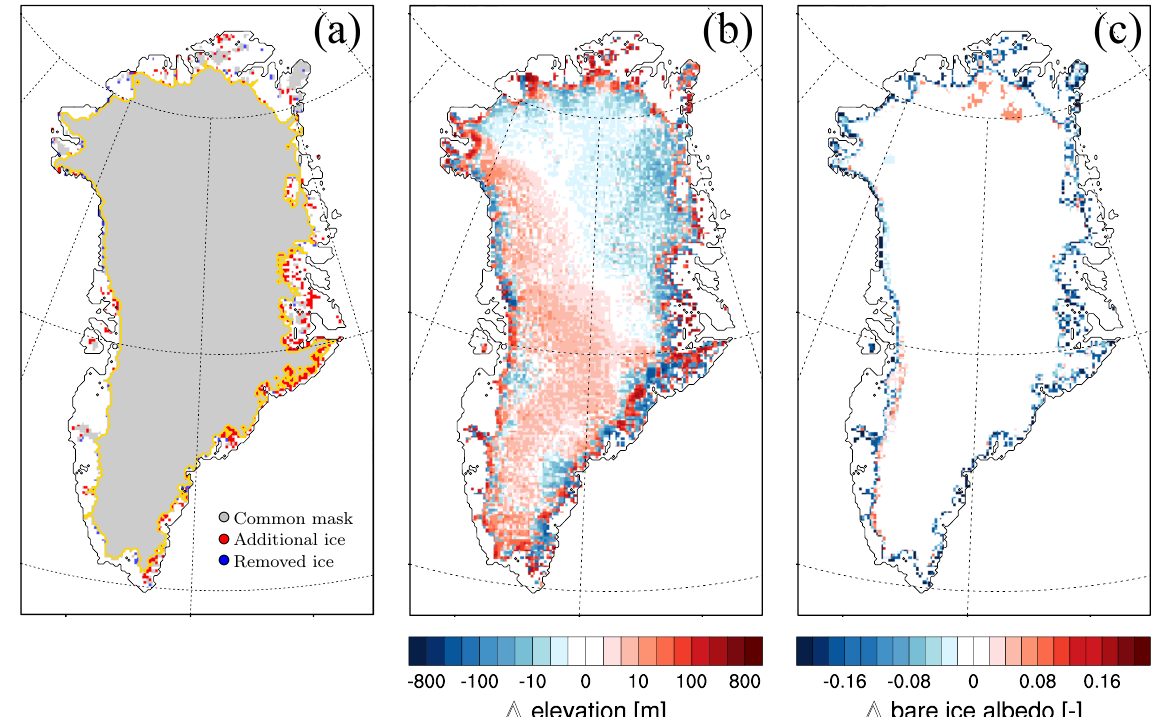
Figure 2. Difference in (a) ice mask (b) surface elevation and (c) bare ice albedo between RACMO2.3p2 and RACMO2.3p1. In panel (a) , the common ice mask for both model versions is displayed in grey, the ice sheet area is outlined in yellow; additional and removed ice-covered cells in RACMO2.3p2 are shown in red and